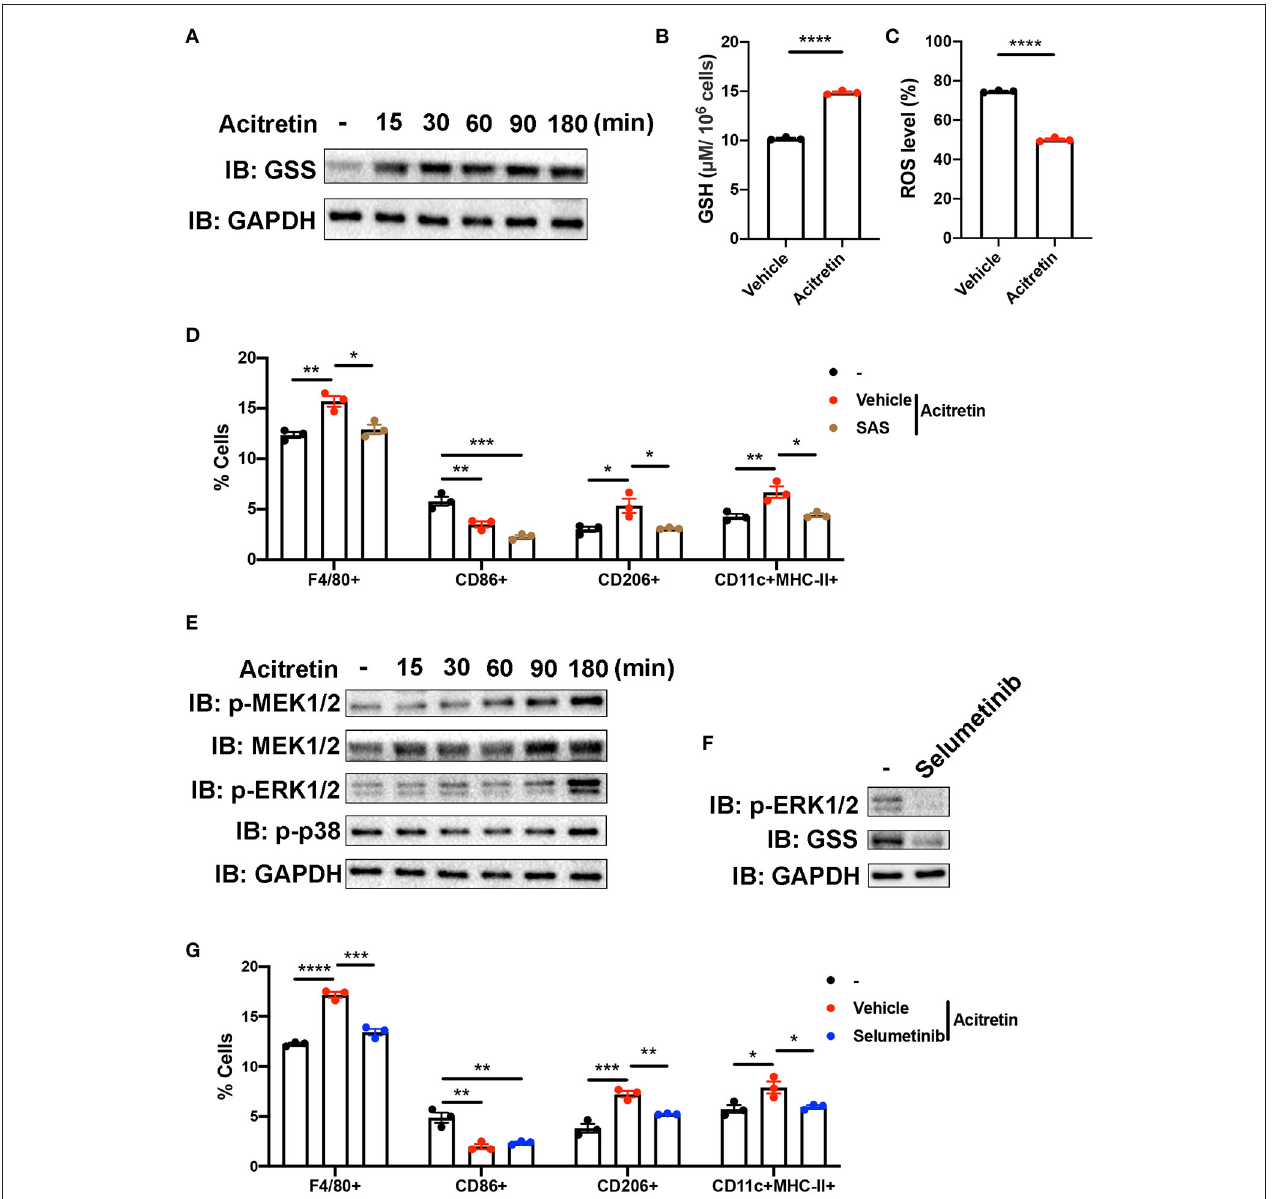
FIGURE 5 | Mechanism of acitretin effect on the differentiation of MDSCs. (A) The effect of acitretin on GSS. Gr-1 + MDSCs were isolated from the bone marrow of IMQ-induced model mice and cultured in the presence of 20ng/mL GM-CSF with or without 500ng/mL acitretin for 15, 30, 60, 90, or 180min. Whole-cell lysates were obtained, and the protein expression of GSS was evaluated in Western blotting as described in Materials and Methods . GAPDH was blotted as a loading control. (B,C) MDSCs from IMQ-induced model mice were treated with vehicle control or 500ng/mL acitretin for 48h as described above. MDSCs were obtained, and the level of GSH was measured with a GSH detection kit. The level of ROS was detected by flow cytometry. (B) The level of GSH in MDSCs. (C) The level of ROS in MDSCs. (D) The effect of SAS combination with acitretin on the differentiation of MDSCs. MDSCs were isolated from the bone marrow of IMQ-induced model mice and cultured for 5 days with 20ng/mL GM-CSF. Acitretin 500ng/mL or SAS 200 µ M was added on days 1 and 3. The presence of different cell populations was evaluated by flow cytometry. (E) Western blot analysis of different proteins in MDSCs after treatment with acitretin. (F) The effect of selumetinib on MDSCs. MDSC were isolated from IMQ-induced model mice and cultured in the presence of 20ng/mL GM-CSF with or without 10nM specific MEK1/2 inhibitor selumetinib for 3h. Cell lysates were prepared, and the protein expression of GSS and p-ERK1/2 was evaluated in Western blotting. GAPDH was blotted as a loading control. (G) The effect of selumetinib combination with acitretin on the differentiation of MDSCs. MDSCs were isolated from the bone marrow of IMQ-induced model mice and cultured for 5 days with 20ng/mL GM-CSF. Acitretin 500ng/mL or selumetinib 10nM was added on days 1 and 3. The presence of different cell populations was evaluated by flow cytometry. Data represent the mean ± SEM. * p < 0.05, ** p < 0.01, *** p < 0.001, **** p < 0.0001.